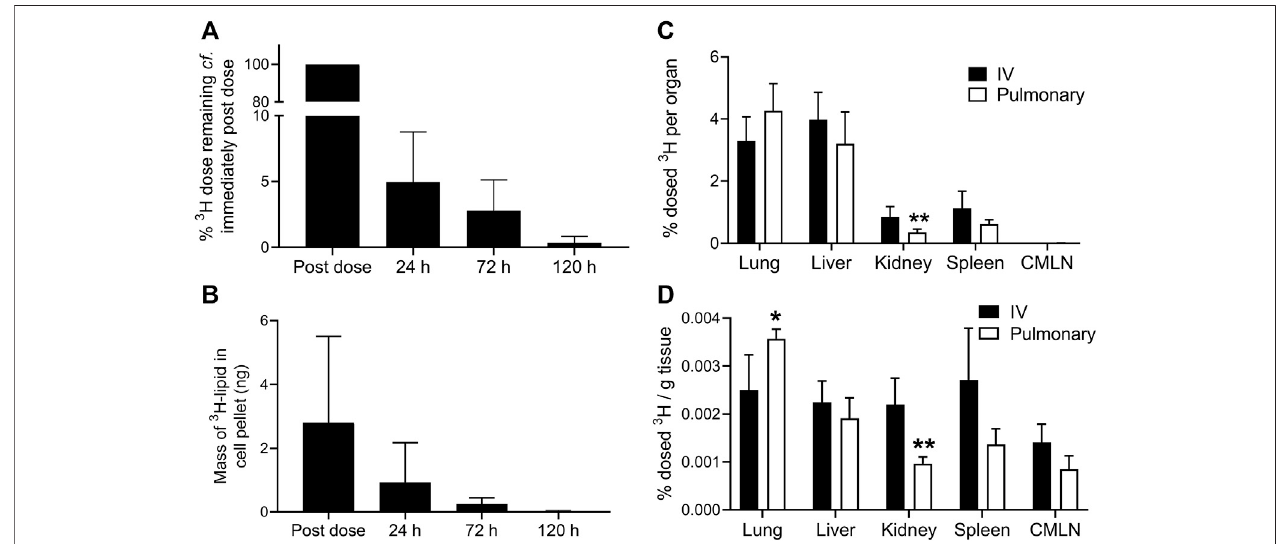
FIGURE 2 | Biodistribution of 3 H-lipid after IV or pulmonary administration of 3 H-liposomes to sheep. (A) % Change in 3 H-lipid concentration of cell-free BALF in sheep over time compared to immediately after the completion of pulmonary dosing. (B) Mass of 3 H-lipid recovered in BALF cell pellets over time after pulmonary delivery. (C) Biodistributionofdosed 3 H-lipidinwholeorgansandtissues5 daysafterviaintravenousorpulmonarydosing. (D) Massnormalizedbiodistributionofdosed 3 H-lipid(%dosepergramoftissue)5 daysafterIVorpulmonarydosing.Datarepresentmean±SD( n =4).*P < 0.05,**P < 0.01comparedtoIVdosing via two-way ANOVA with Sidaks Multiple Comparison